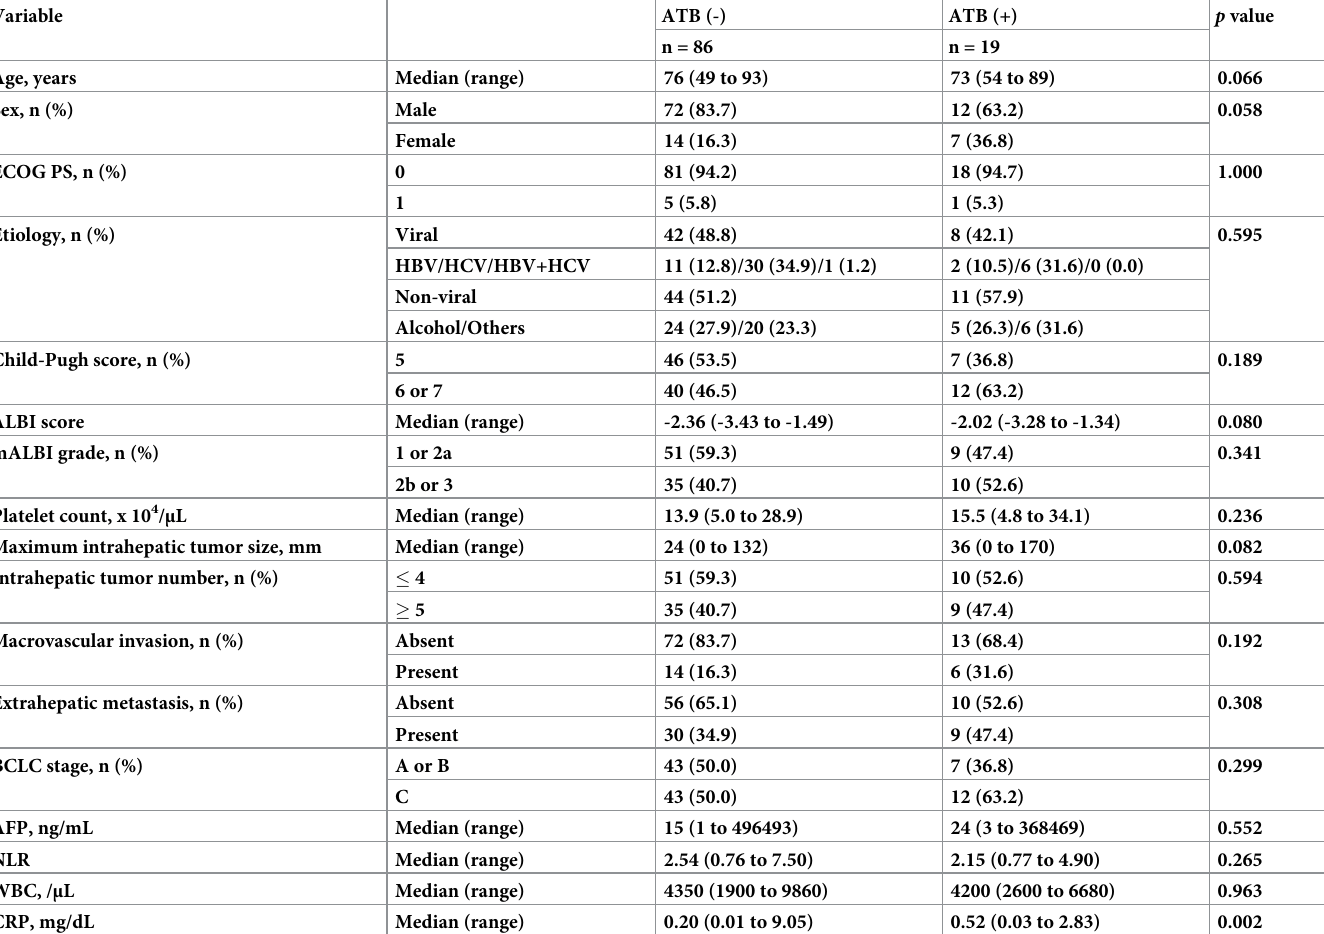
Table 1. Comparisons of the characteristics between the ATB (-) and ATB (+) groups.